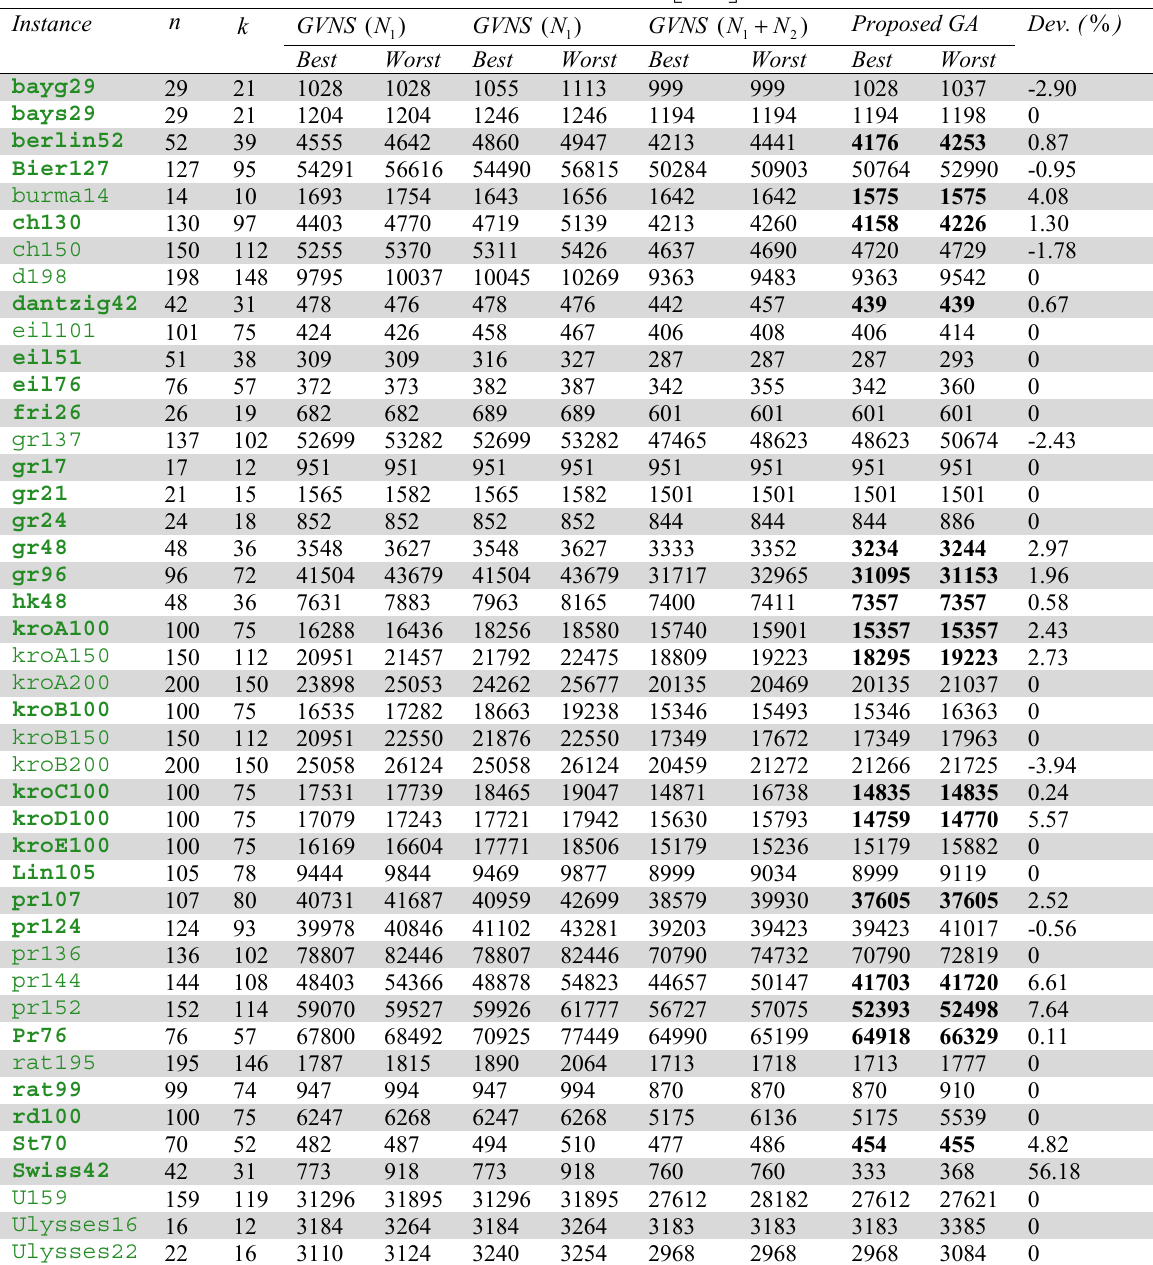
Results of proposed GA Vs. GVNS on benchmark instances